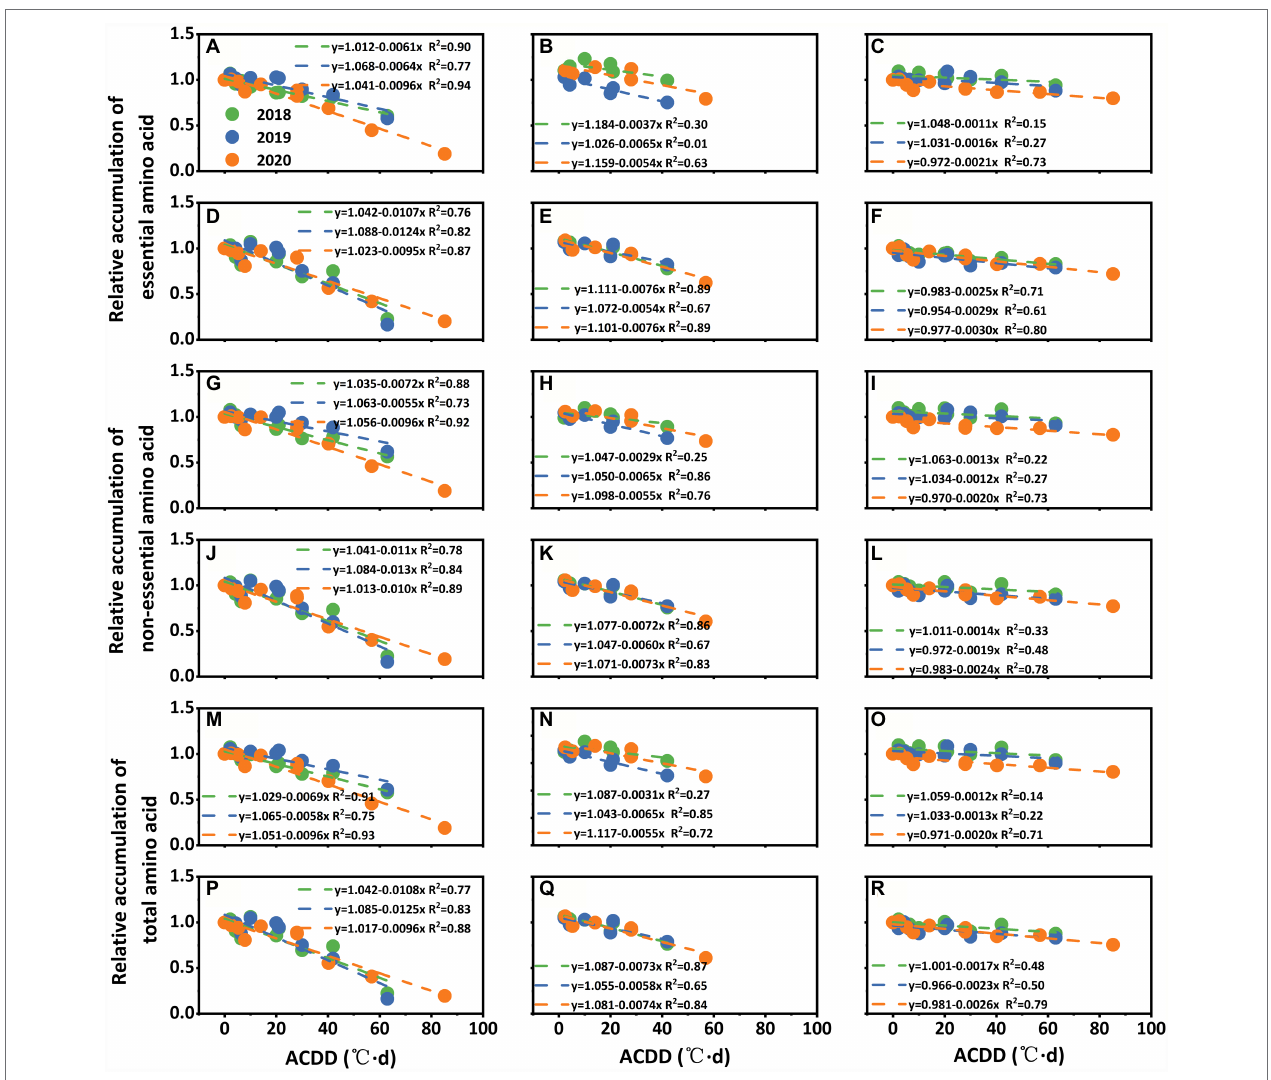
FIGURE 5 | Relationship between low-temperature stress at early flowering (A,D,G,J,M,P) , peak flowering (B,E,H,K,N,Q) , and grain filling (C,F,I,L,O,R) stages and the relative accumulation of amino acids in Huaidao 5 (A–C,G–I,M–O) and Nanjing 46 (D–F,J–L,P–R) at maturity. ACDD: accumulated cold degree days. Three different colors indicate results from three growing seasons in 2018–2020. (A–F) present the relative accumulation of essential amino acids. (G–L) present the relative accumulation of non-essential amino acids. (M–R) present the relative accumulation of total amino acids.